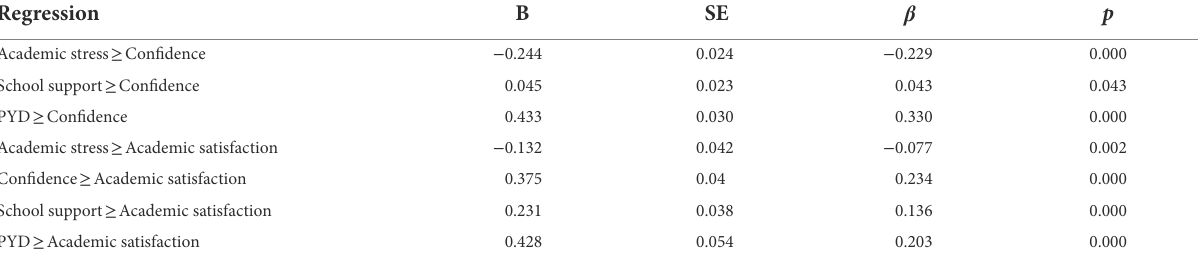
Figure 2, academic stress at Wave 4 negatively predicted academic satisfaction at Wave 6 (direct effect = − 0.077, p < 0.01; see Table 2). In line with our hypotheses, PYD attributes and school support at Wave 4 positively predicted academic satisfaction at Wave 6 (direct effect = 0.203 and 0.136, respectively; p s < 0.001).